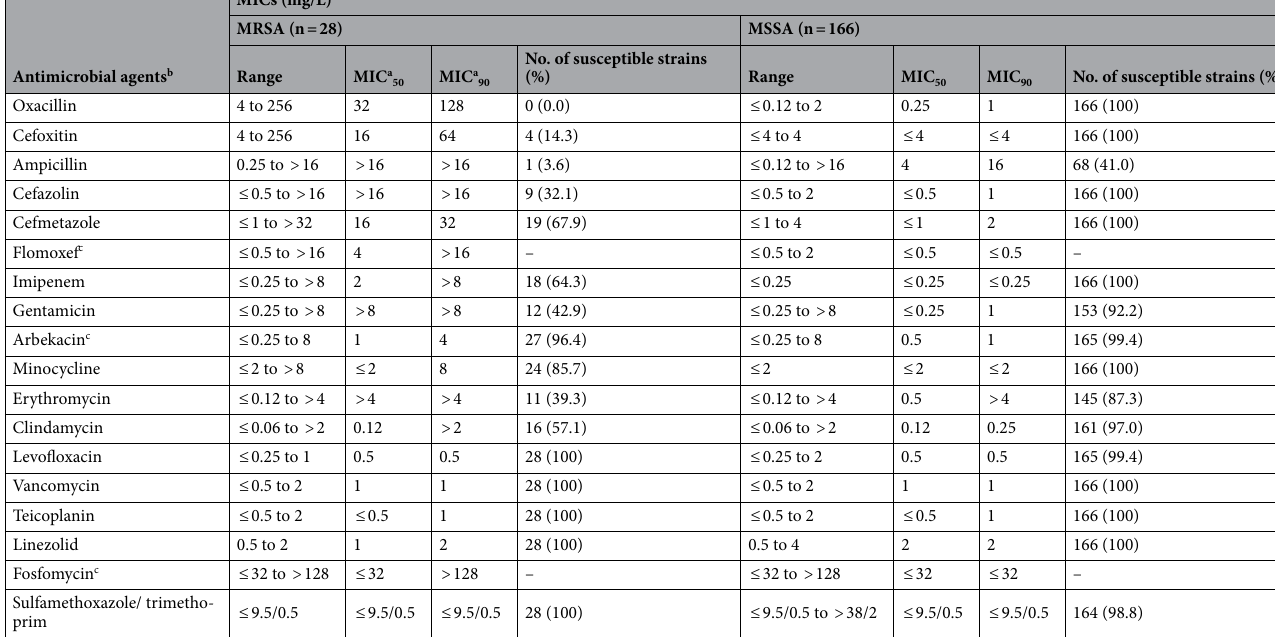
Table 1. Minimum inhibitory concentrations (MICs) of antimicrobial agents against methicillin-resistant and methicillin-susceptible Staphylococcus aureus strains. a MIC 50 /MIC 90 , MIC required to inhibit the growth of 50% or 90% of the strains, respectively. b MICs of oxacillin and cefoxitin were determined by the agar dilution method; all other MICs were determined by the broth microdilution method. c For arbekacin, CLSI breakpoint of gentamicin was used as a substitute; For flomoxef and fosfomycin, no breakpoints were determined by